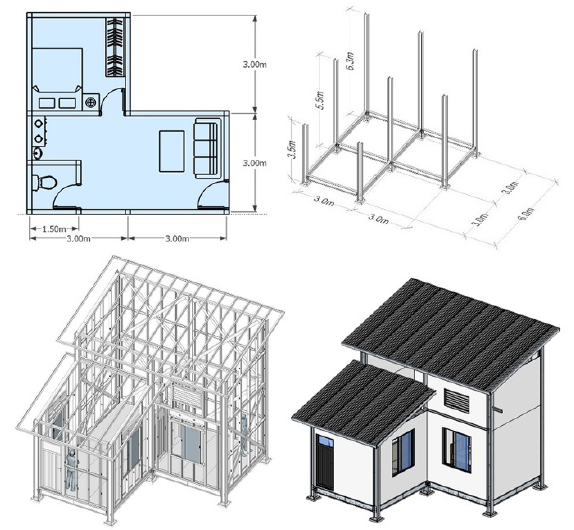
Figure 1. The 3D model for experiment house.